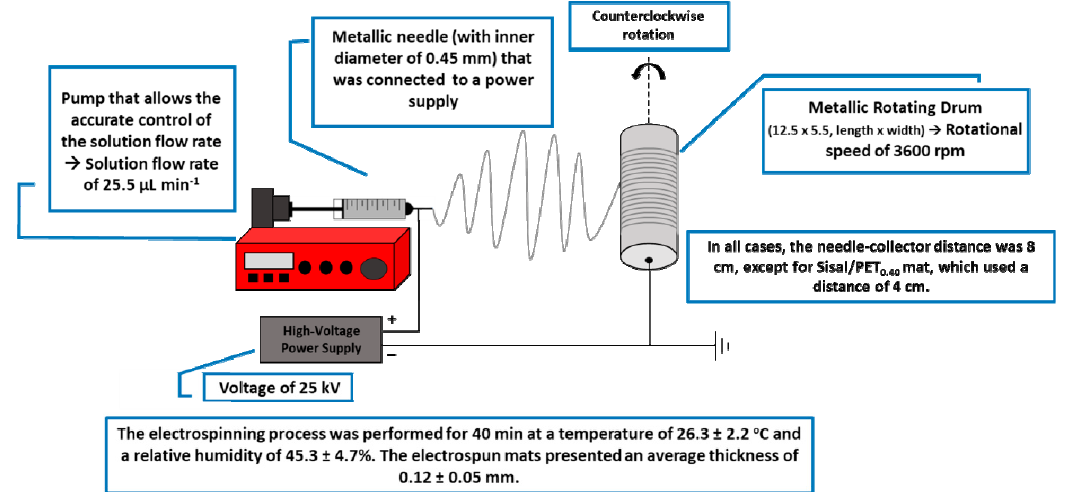
Figure 1. Experimental scheme with the electrospinning parameters adopted.